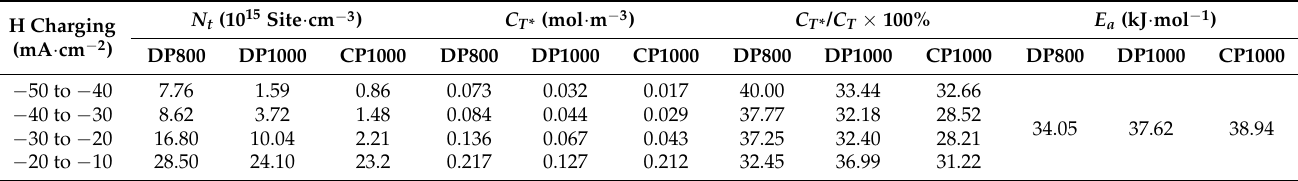
Table 3. The trap density, total amount of hydrogen released, and the activation energy of the specimens obtained from the fall transient of the permeation